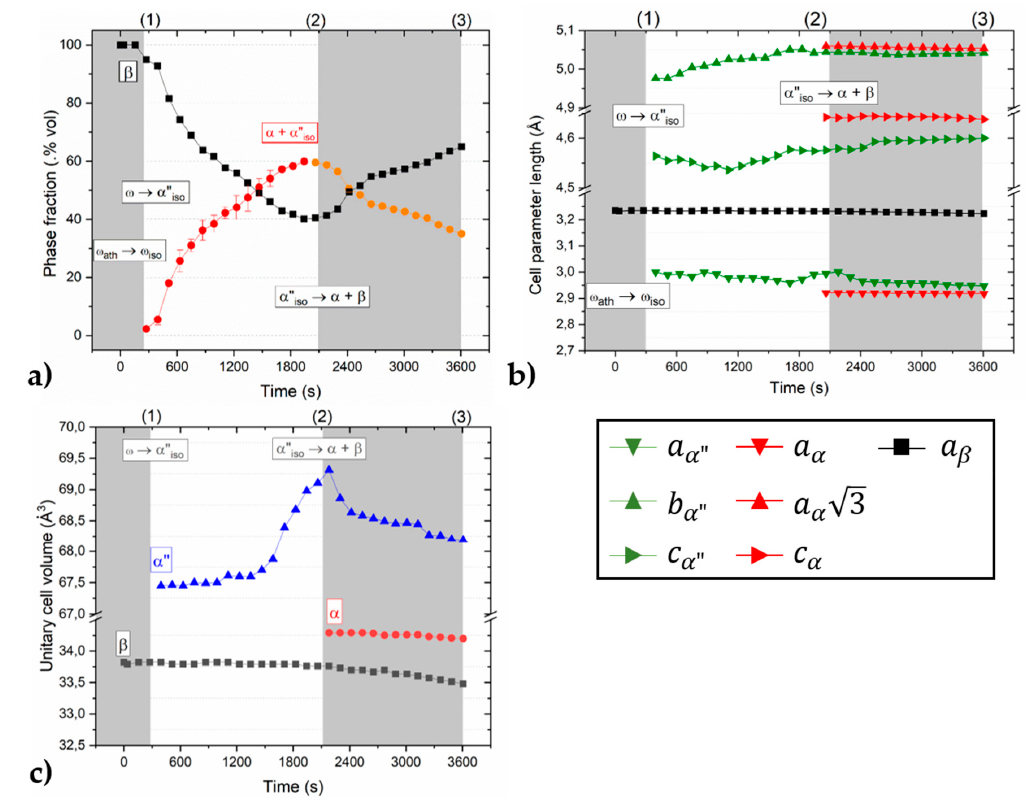
Figure 7. Evolution of ( a ) volume fractions, ( b ) lattice parameters, and ( c ) unit cell volume of phases during ageing at 500 ◦ C for 3600 s of Ti-55531 alloy.